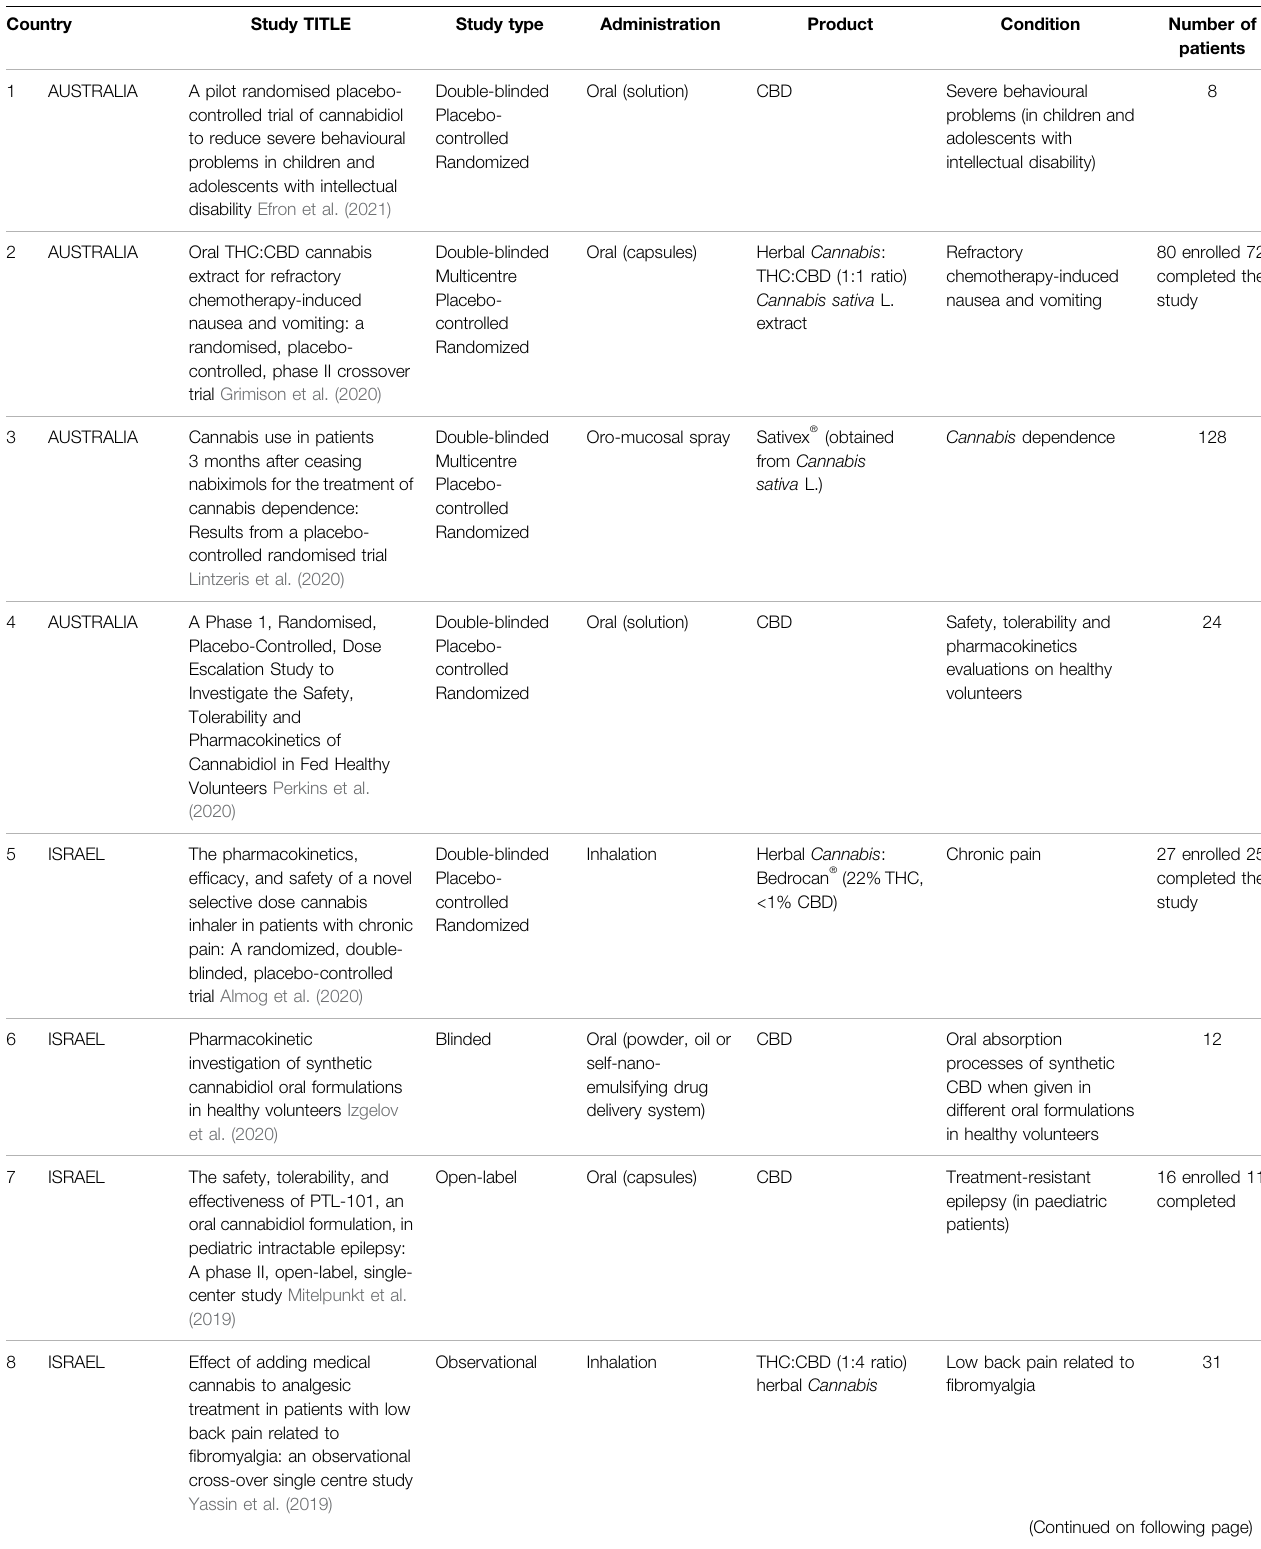
TABLE 1 | Characteristics of the selected clinical trials. Clinical trials with a POSITIVE outcome